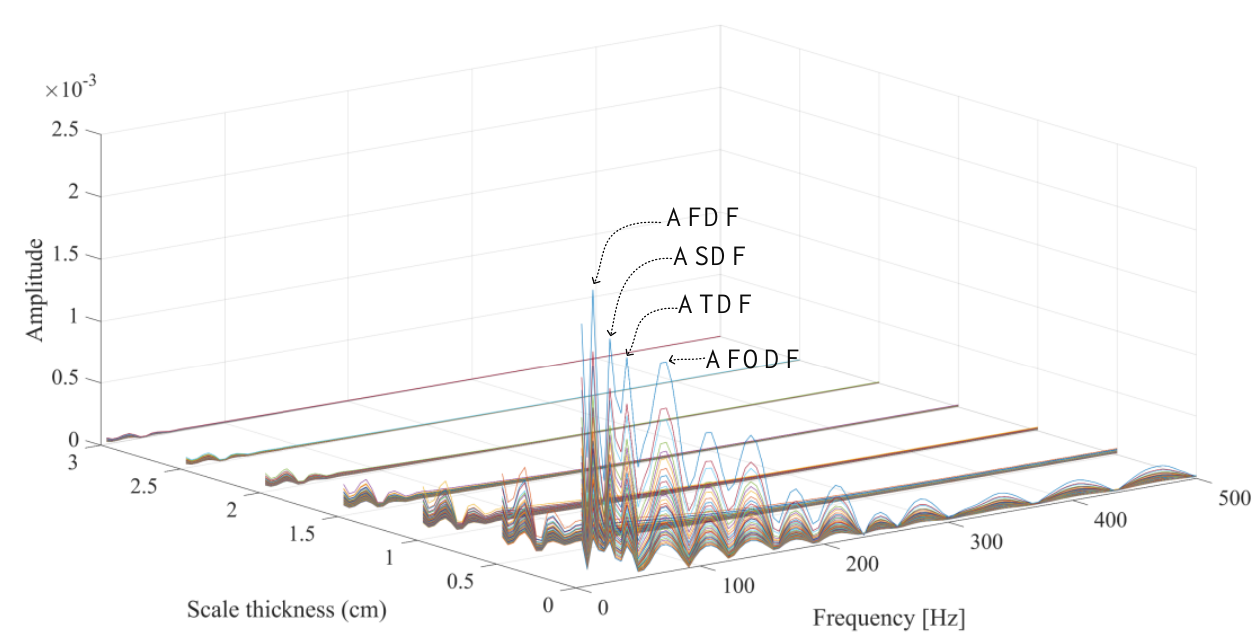
Figure 3. Frequency domain signals.